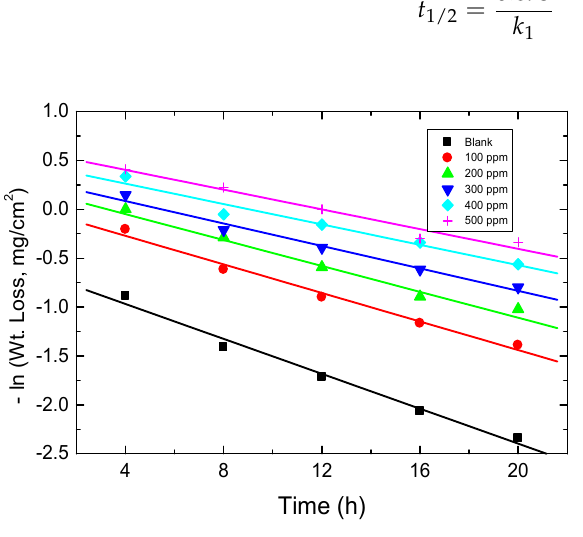
Figure 17. First-order plots for mild-steel corrosion in 0.5 M HCl solution in absence and presence of chitin at 303 K. Table 7. Values of k 1 and t 1/2 for mild-steel corrosion in 0.5 M HCl solution in the absence and pres- ence of chitin at 303 K.